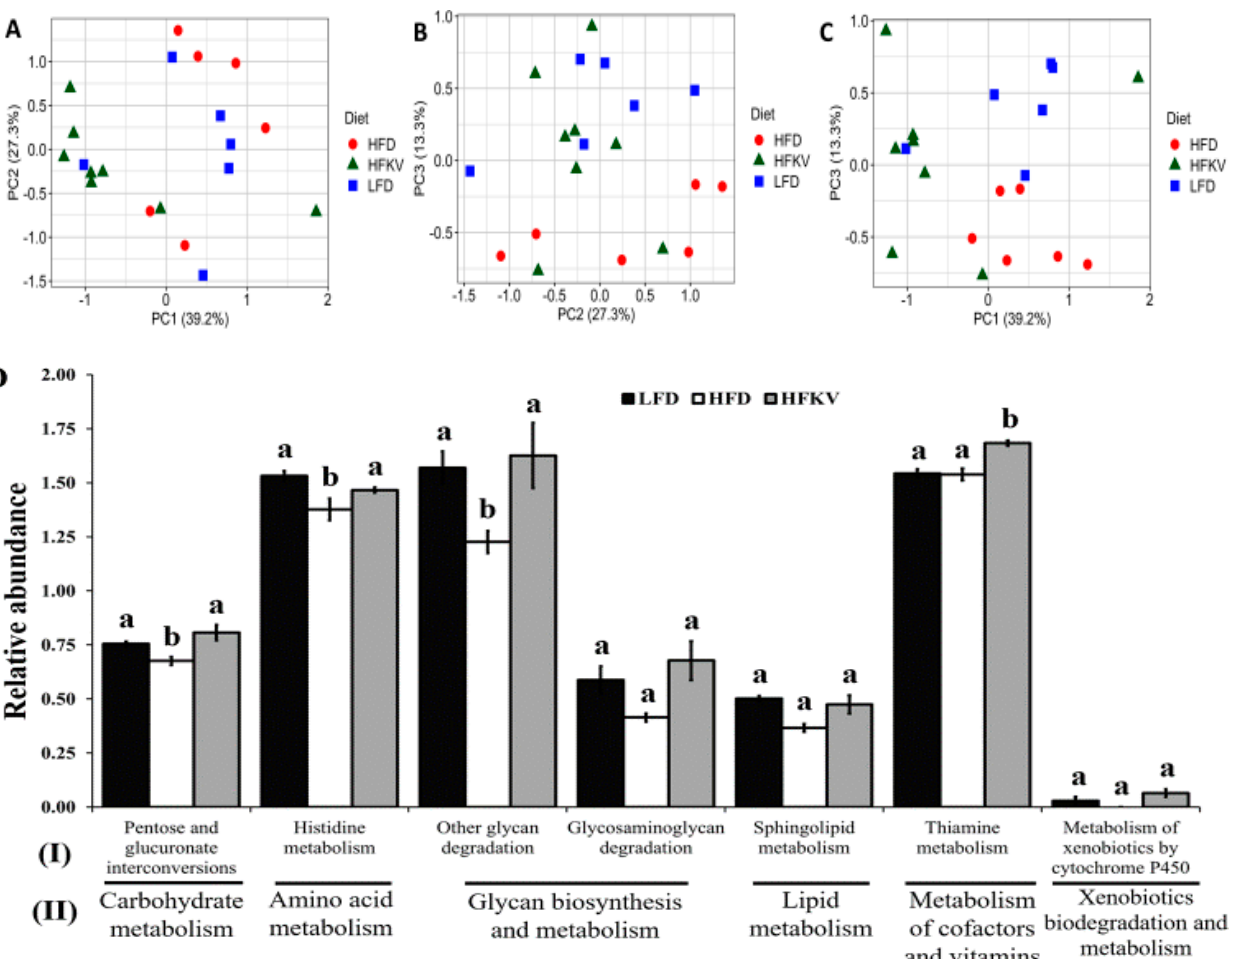
Figure 4. Predicted metabolic pathways by PICRUSt2 using 16s rRNA gene sequences. ( A – C ) PCA plots representing the pathways predicted from Kyoto Encyclopedia of Genes and Genomes (KEGG) Ortholog (KO) database. Data points represents the distribution of principal components in two different directions ( x - and y -axis) and the closer the data points, the closer the relationship between the samples. HFKV clustered closer to LFD; ( D ) Microbiota metabolic functions showing significant differences between HFD and HFKV. Significant differences with LFD-induced pathways are indicated by different letters ( p < 0.05). (I) KEGG pathways at level 1; (II) KEGG pathways at level 2. The letters ‘a’ ‘b’ denote statistically significant values at p <